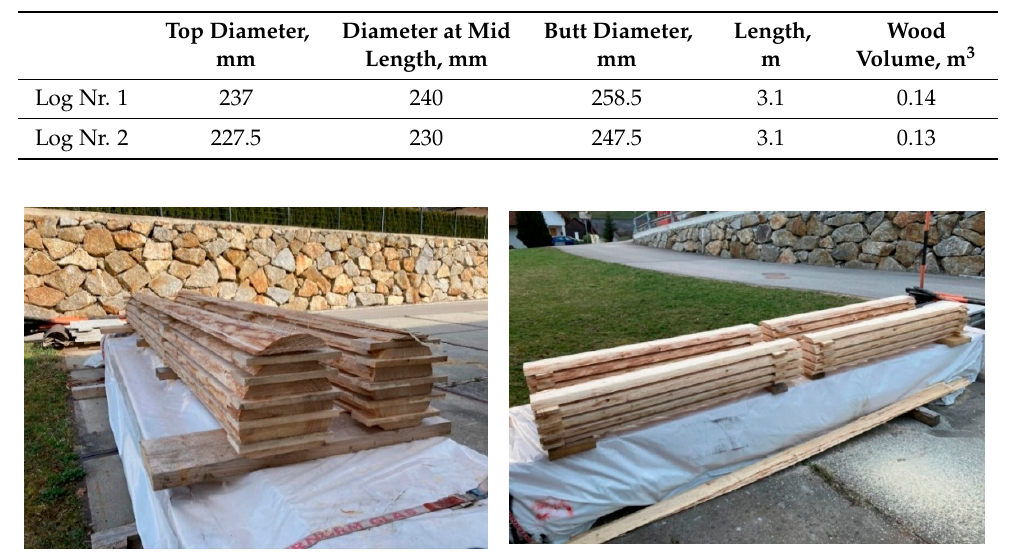
Figure 1. Experimental pieces of lumber obtained after bandsawing and sectioning.